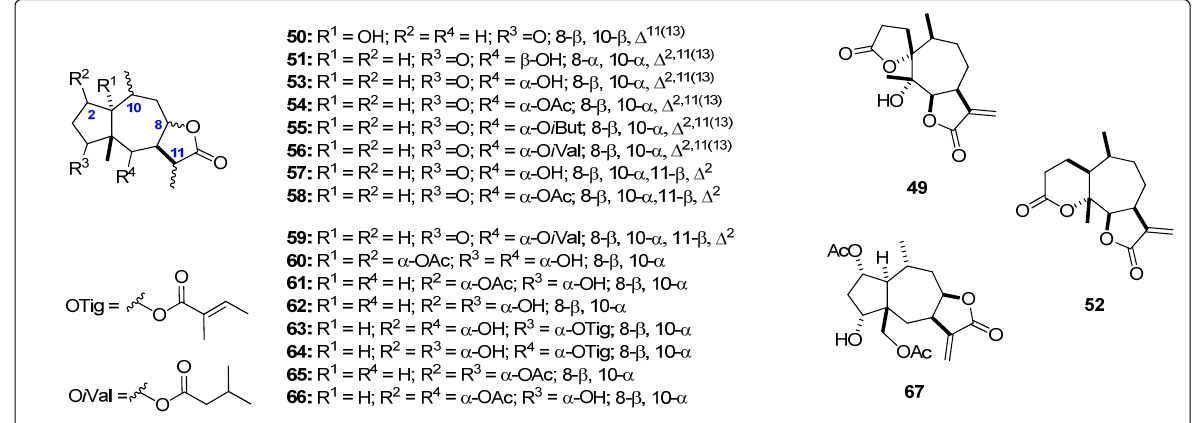
Figure 4. Structures of the tested pseudoguaianolide sesquiterpenes